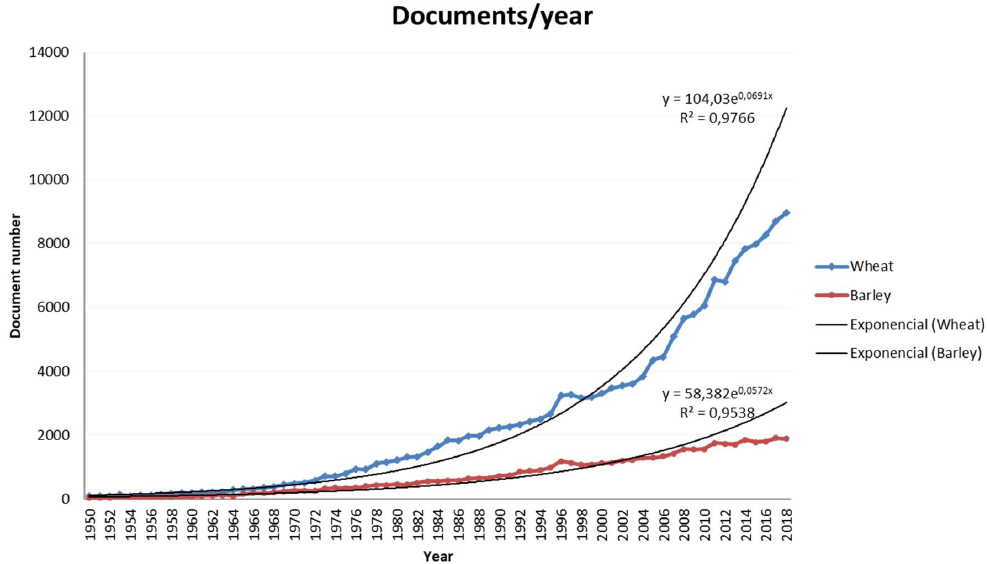
Figure 1. Trends in publications on Wheat and Barley research fields.